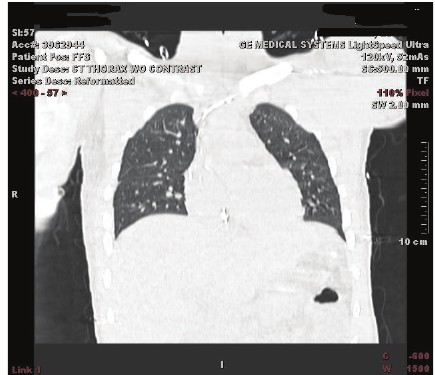
Figure 5: Confirmatory CT of radiopaque catheter, 10cm, tubing extending from retrohepatic IVC through the right atrium into the low SVC.